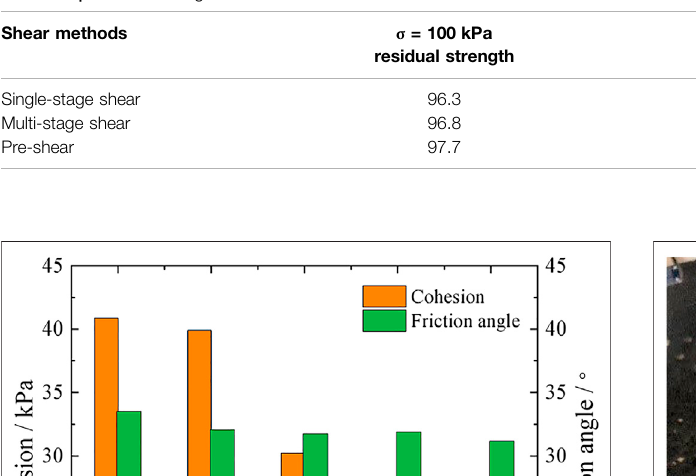
TABLE 4 | Residual strength values under different shear methods.